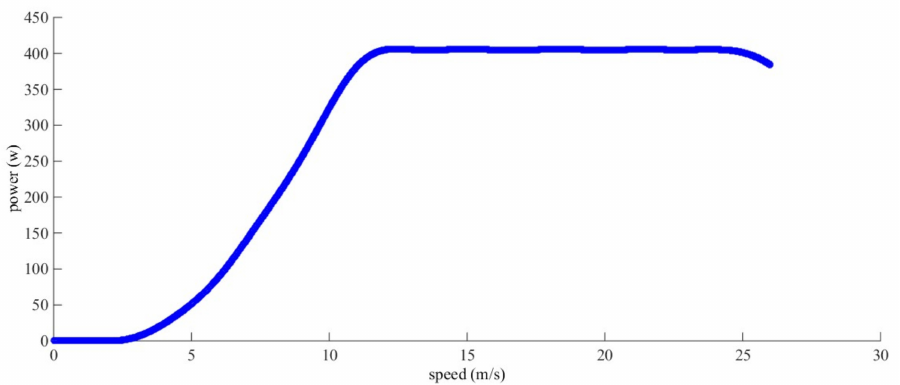
Figure 4. Wind speed-output power